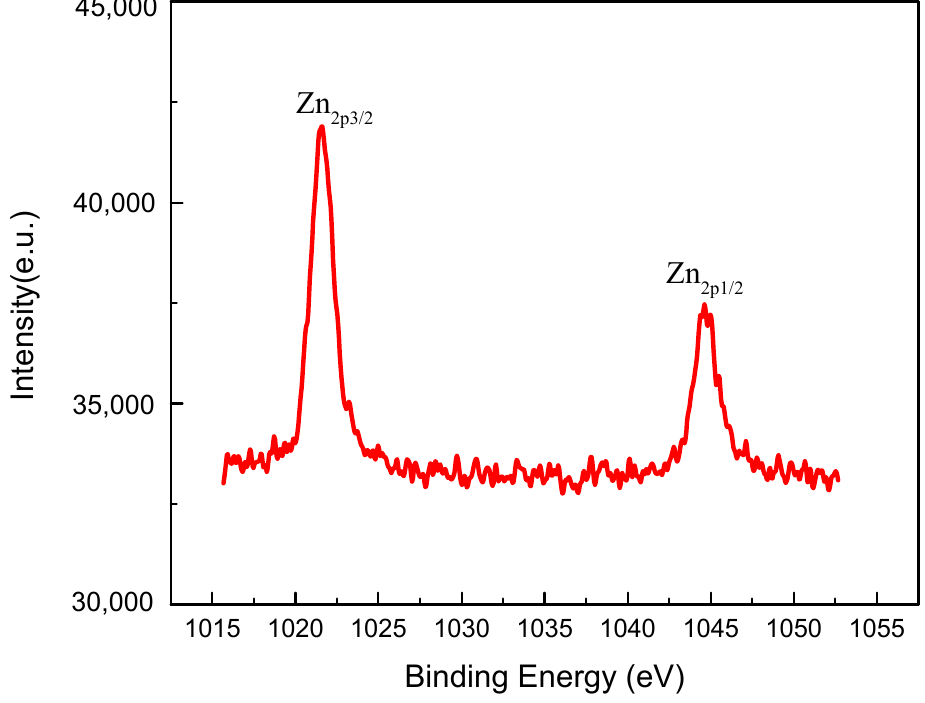
Figure 11. The XPS spectrum of Zn in hydrochar S5C5 after H 2 S adsorption. During the hydrothermal reaction, CuCl 2 and ZnCl 2 reacted to form CuO and